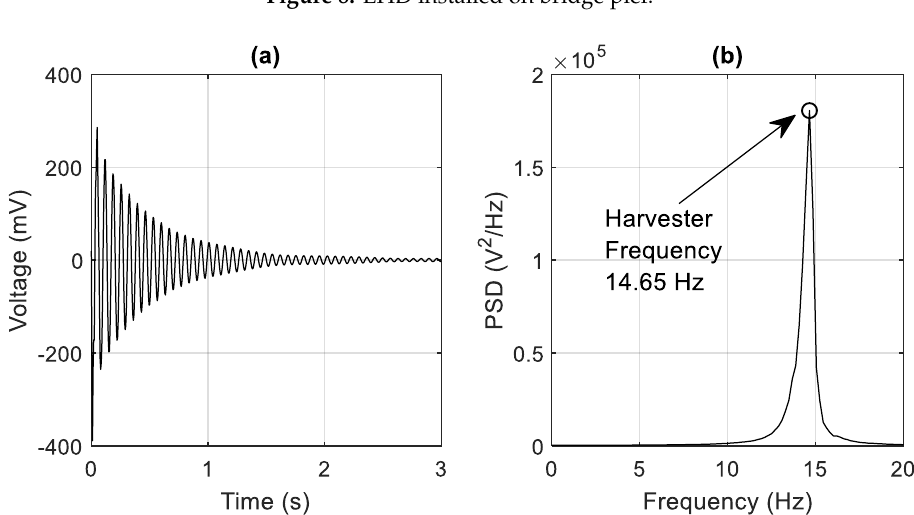
Figure 9. ( a ) Harvester voltage after impulse load test ( b ) PSD of harvester voltage from load impulse test.